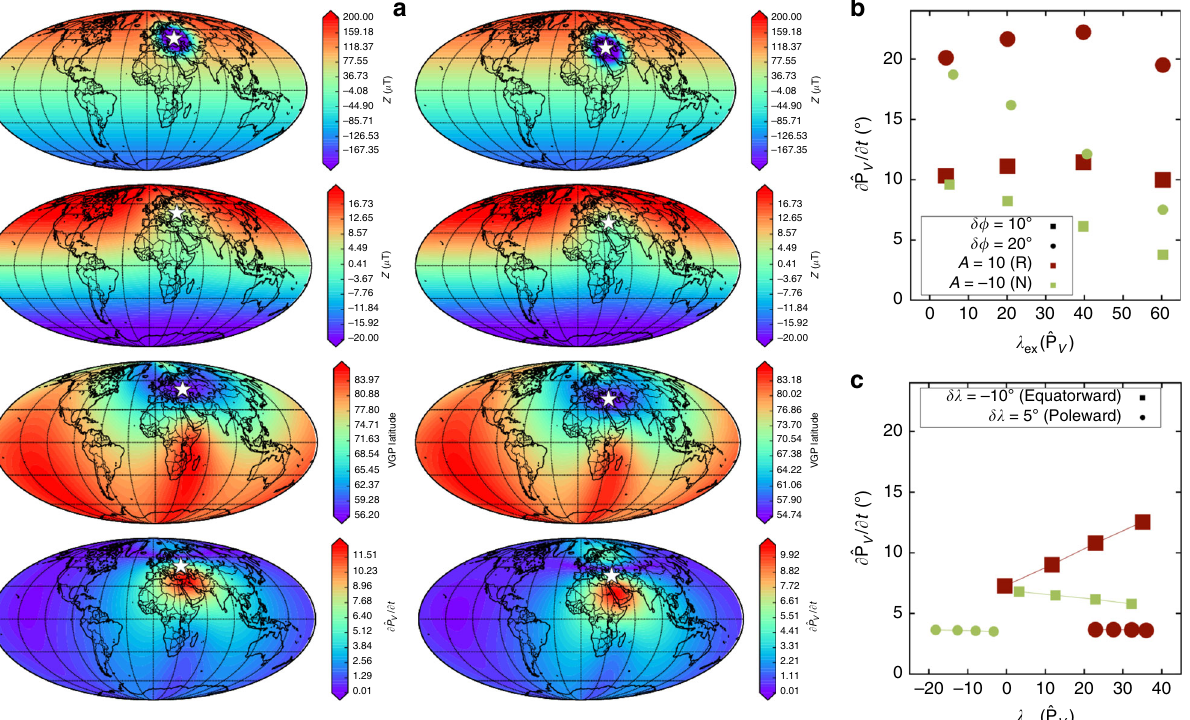
Fig. 4 Directional changes produced by a simple model of a patch of radial fi eld moving across the core surface. a The effect of a reversed fl ux patch of amplitude A = 10 μ T with an initial latitude of 60° moving southward to 50° (left) and then to 40° (right) ( δλ = − 10°). Rows show, respectively, the vertical magnetic fi eld at the CMB and surface, Z , VGP latitude at the surface, and the rate of change of VGP position ∂ ^ P V = ∂ t . The centre of the patch on ð ^ P Þ , of the fastest directional changes for normal ( A < 0, denoted N) and the CMB is denoted by the star. b , c The amplitudes, ∂ ^ P V = ∂ t , and locations, λ V ex reversed ( A > 0, denoted R) polarity patches. In b , patches initially at 5°, 20°, 40° and 60° latitude are moved longitudinally in increments of δϕ = 10° (squares) and 20° (circles). In c patches initially placed at 40° longitude are moved equatorward and poleward in increments of δλ = − 10° and δλ = 5°, respectively. In all cases in b , c ∂ ^ P V = ∂ t is largest for reversed